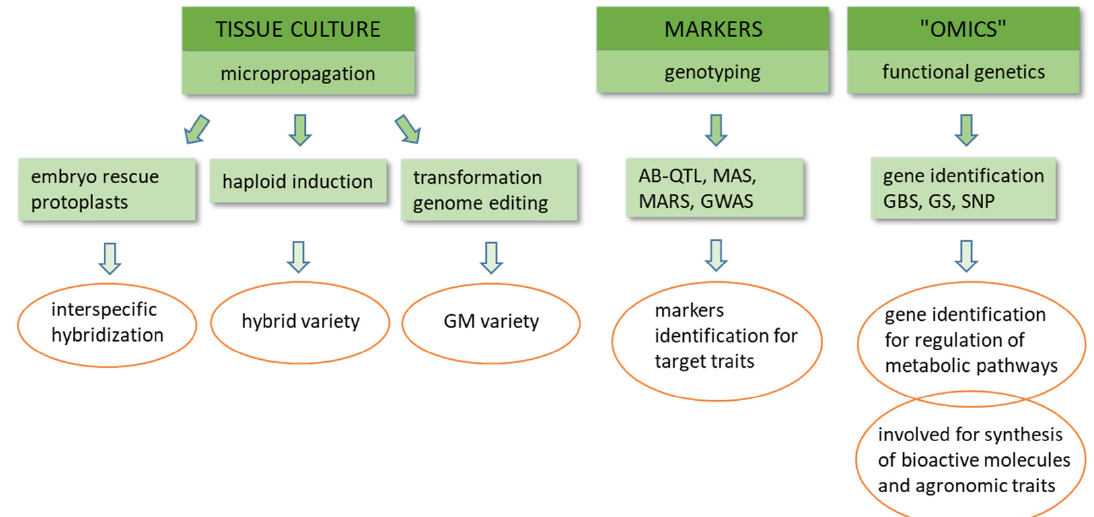
Figure 2. Integrative genomics and breeding approaches for accelerated genetic improvement of buckwheat: GM—genetically modified, AB-QTL—advanced backcross quantitative trait locus, MAS—marker assisted selection, MARS—marker assisted recurrent selection, GWAS—genome wide association study, OMICS—refers to a field in biological sciences such as genomics, transcriptomics, proteomics, and metabolomics, GBS—genotyping by sequencing, GS—genomic selection, SNP—single nucleotide